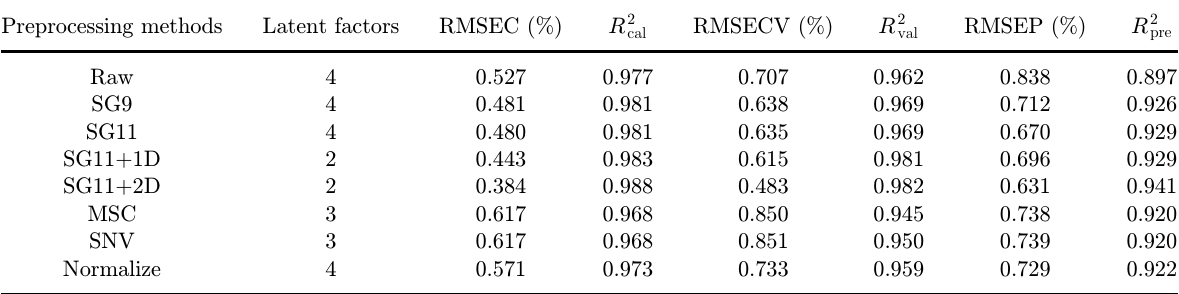
Table 2. Di®erent pretreatment methods of PLS model. Preprocessing